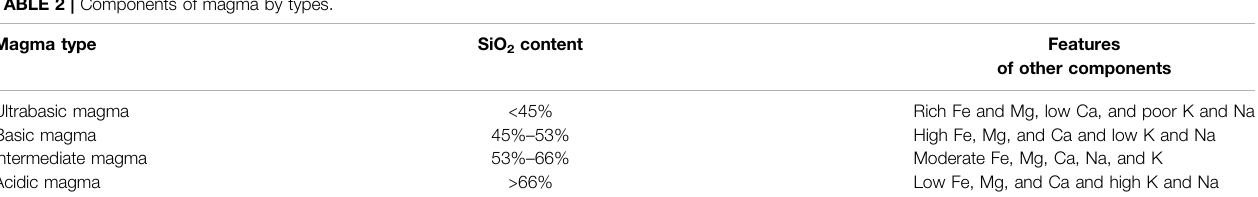
TABLE 2 | Components of magma by